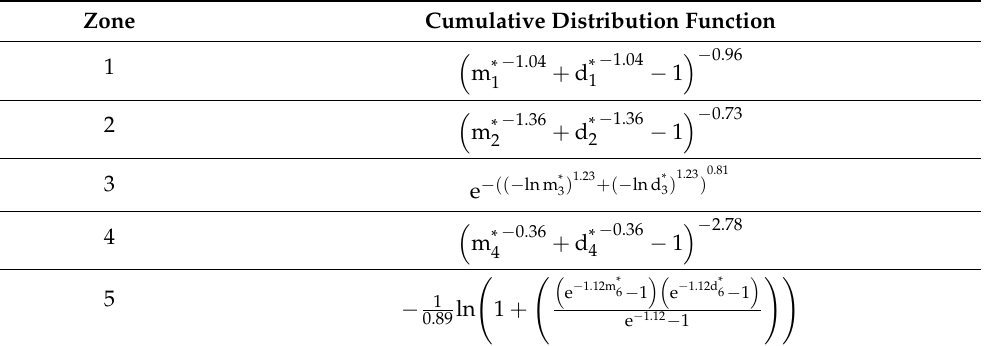
Table 16. The joint CDF of magnitude and depth of earthquakes in Cluster Type I. Zone